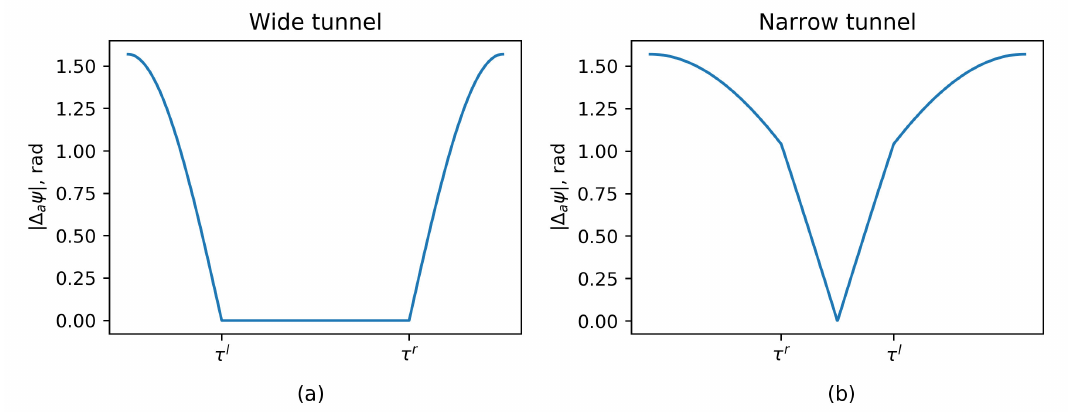
Figure 7. Yaw angle correction in wide and narrow tunnels. Notice that in the narrow tunnel case, the right wall reactive distance τ r is at the left of the left wall reactive distance τ l . ( a ) Wide tunnel case. ( b ) Narrow tunnel